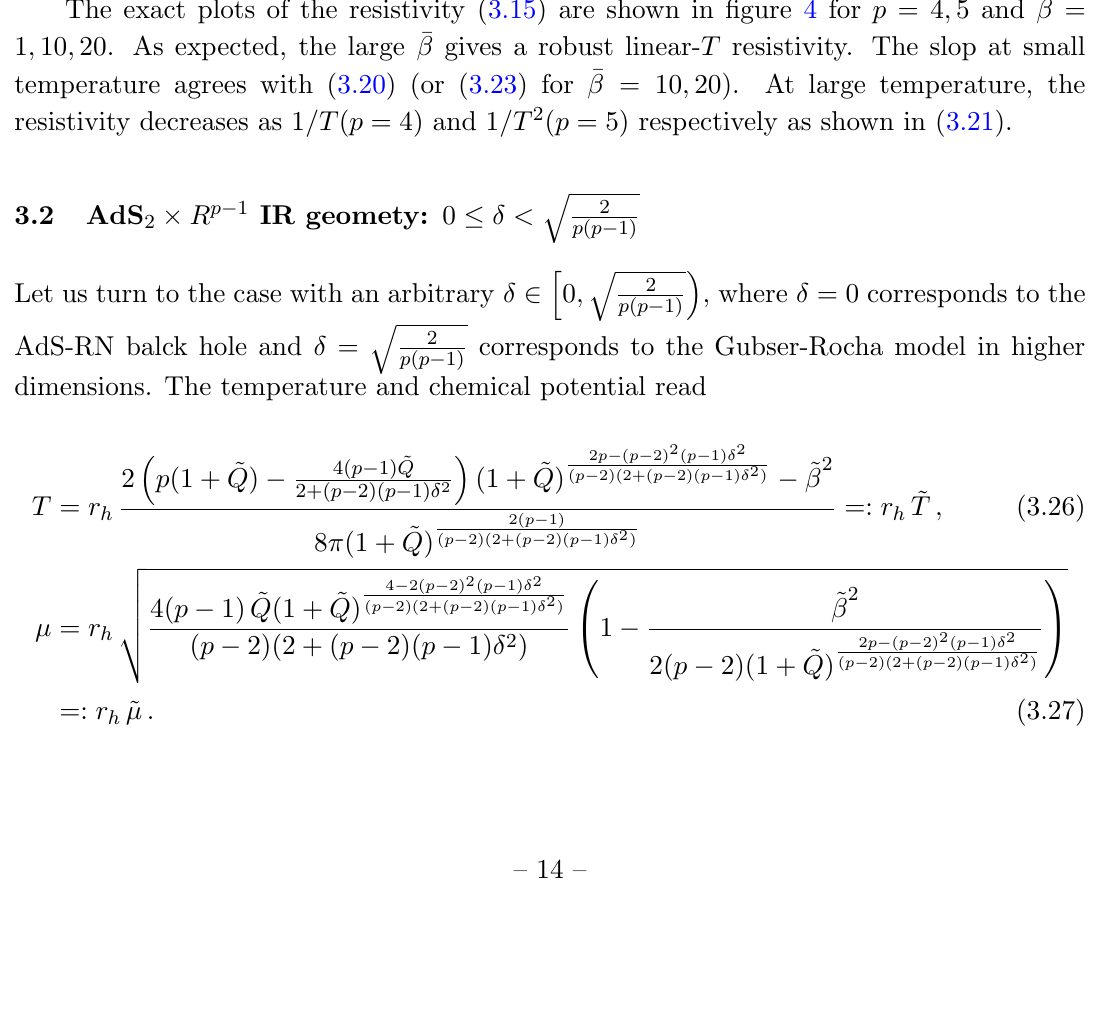
for strong DC (3.14) and (cid:22) (3.16). DC